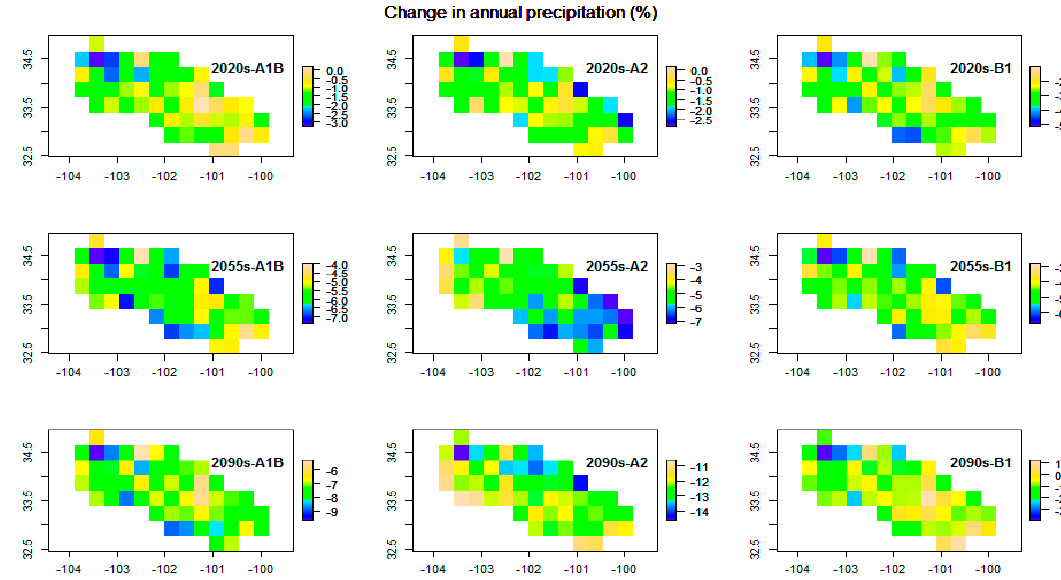
Figure 5. Spatial maps of percentage changes in annual precipitation compared with the baseline period (maps are not to scale).